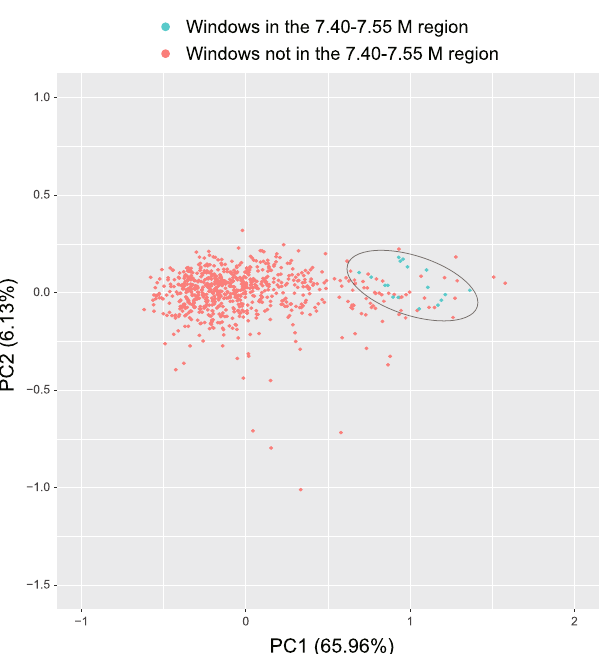
Figure 6. PCA analysis of codon usage frequency of Paenibacillus sp. SSG-1. The X and Y axes represent the scores of the first two principal components and each dot denotes 20 kb genome